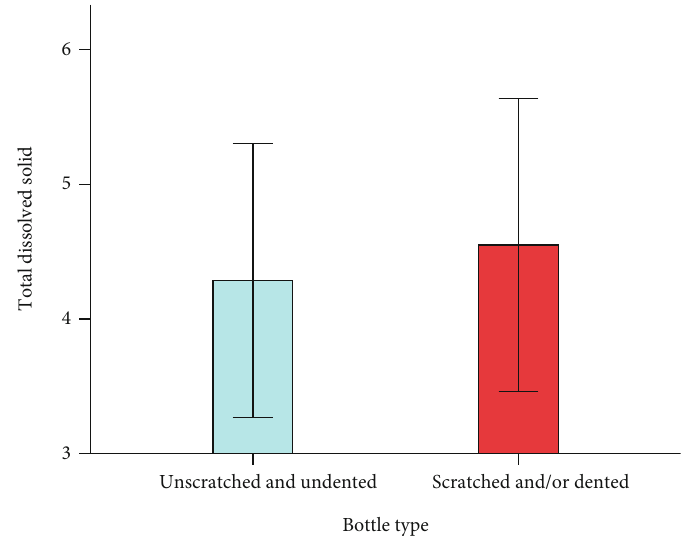
Figure 3: Distribution of the TDS value with respect to the physical condition of the bottled water vessel.